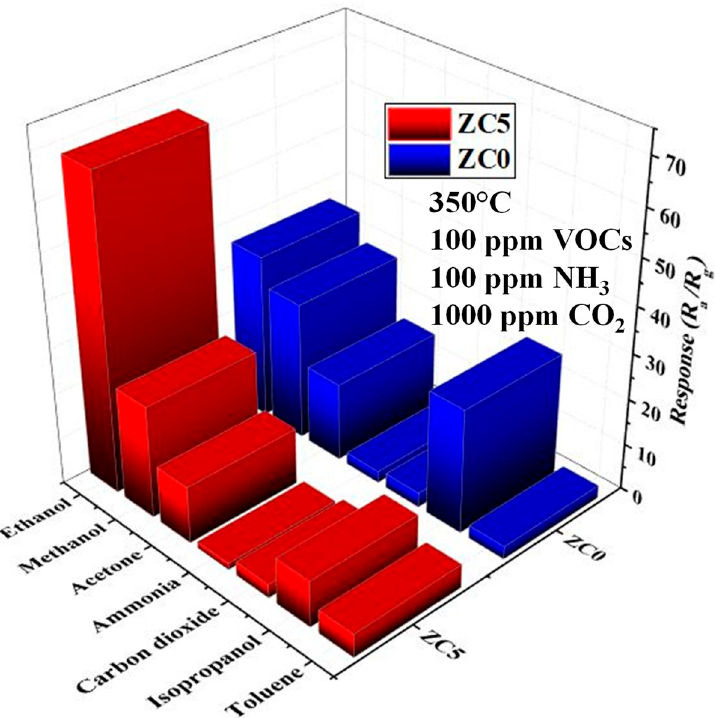
Figure 12. Selectivity patterns of ZC0 and ZC5 gas sensors to different gases at 350 °C.